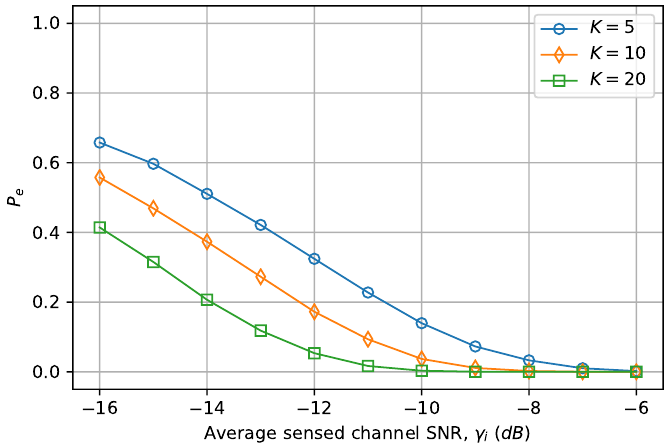
Figure 10. Sensing error with the proposed CBCSS according to average SNRs when the number of SUs, K ,